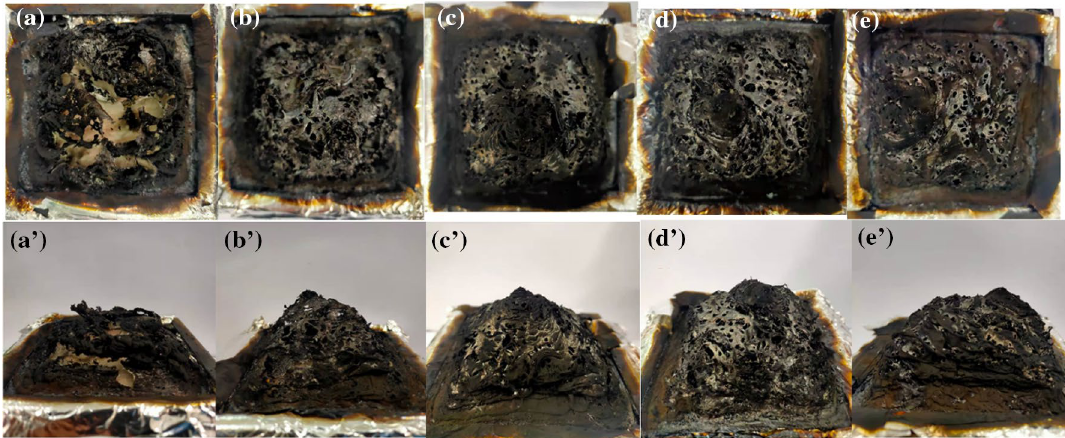
Figure 5. Video screenshots of char residues from cone calorimeter tests of ( a and a ′ ) EP, ( b and b ′ ) 5DOPO- CuPc/EP, ( c and c ′ ) 10DOPO-CuPc/EP, ( d and d ′ ), 15DOPO-CuPc/EP, ( e and e ′ ) 20DOPO-CuPc/EP.